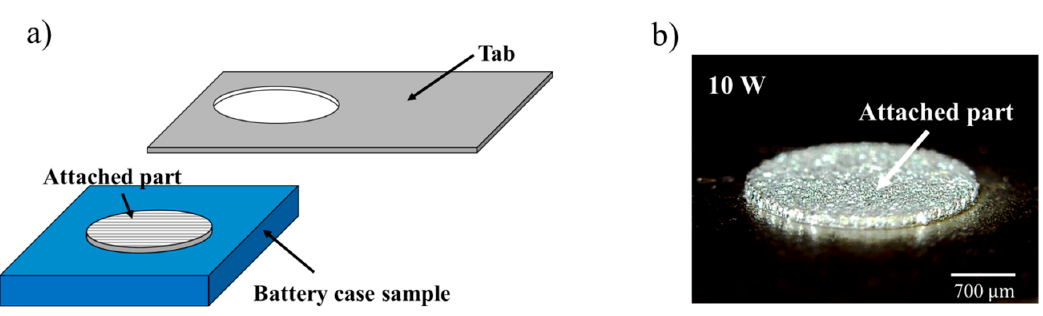
Figure 10. ( a ) Schematic of the attached tab after the tensile test; ( b ) attached tab at the laser power 10 W.